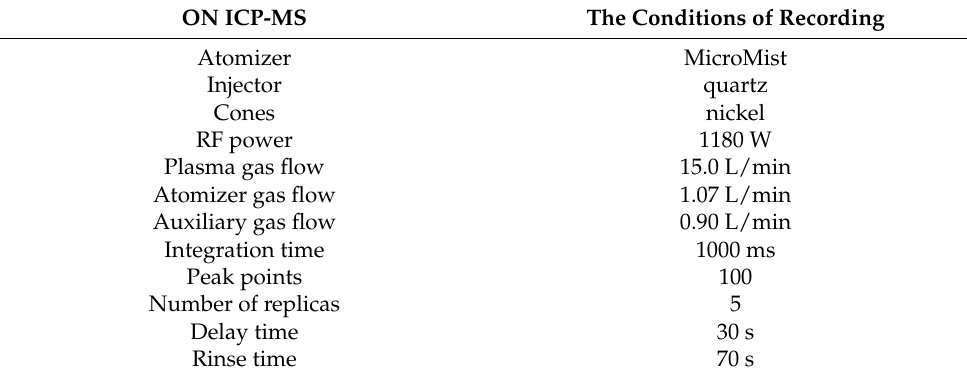
Table 1. Conditions of recording on ICP-MS. ON ICP-MS The Conditions of Recording Atomizer MicroMist